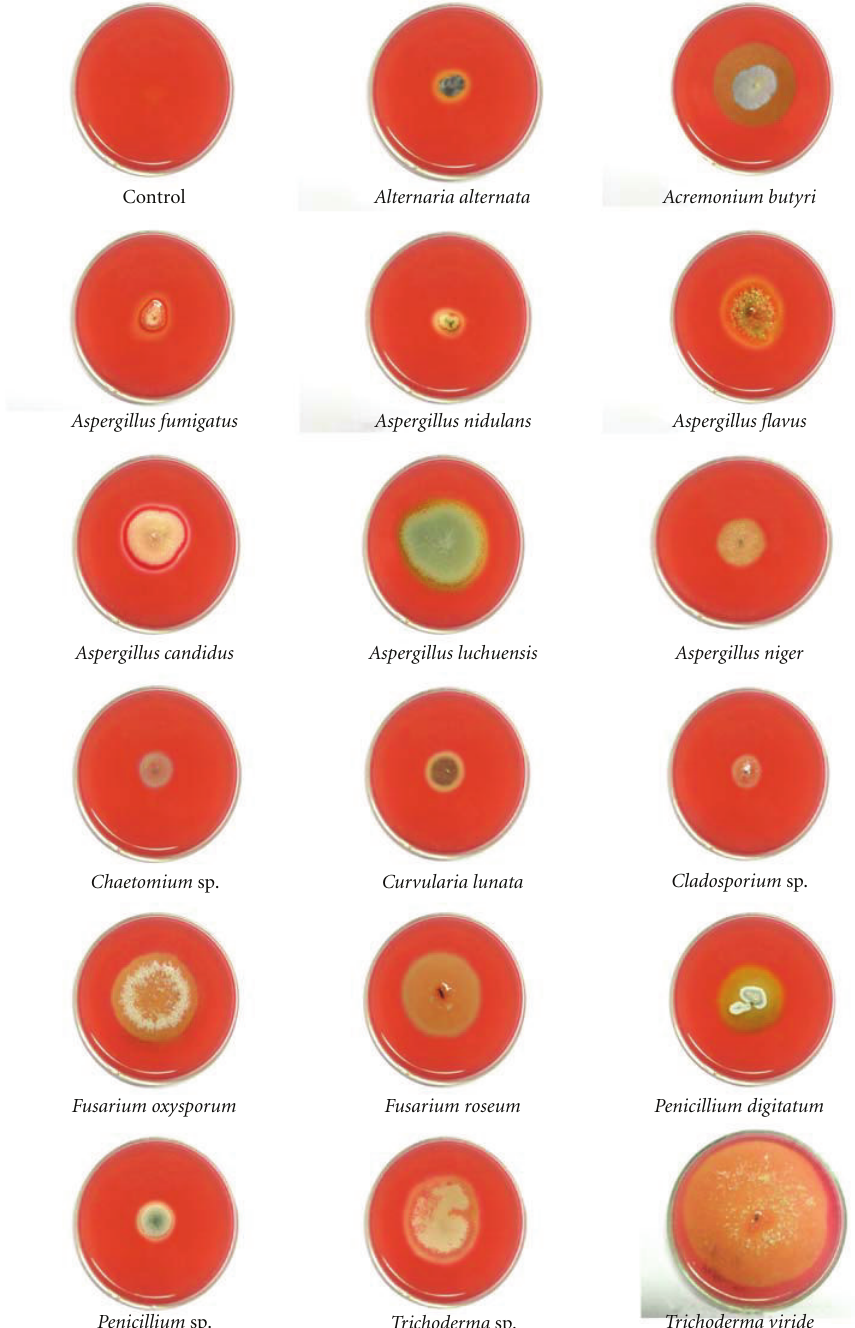
Figure 2: Primary screening of fungi isolated from di ff erent